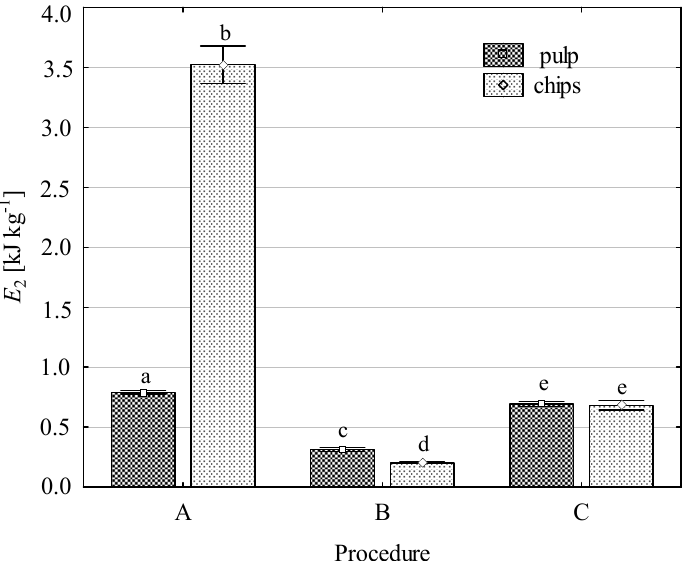
Figure 8. Impact of applied procedures on the specific energy E 2 in the second pressing cycle of pomace. Abbreviations, as in Figure 3. a, b, c, d, and e—average values marked with the same letter show no statistically significant difference ( p ≤ 0.05).